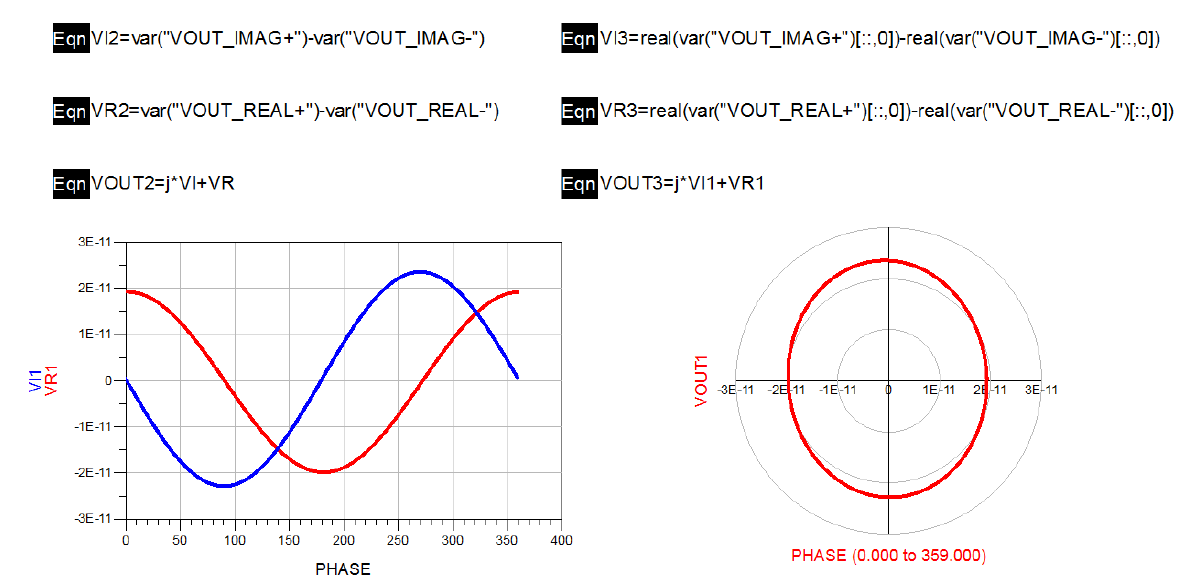
Figure 11. Phase scanning results of the full-power microwave temperature radiometer.